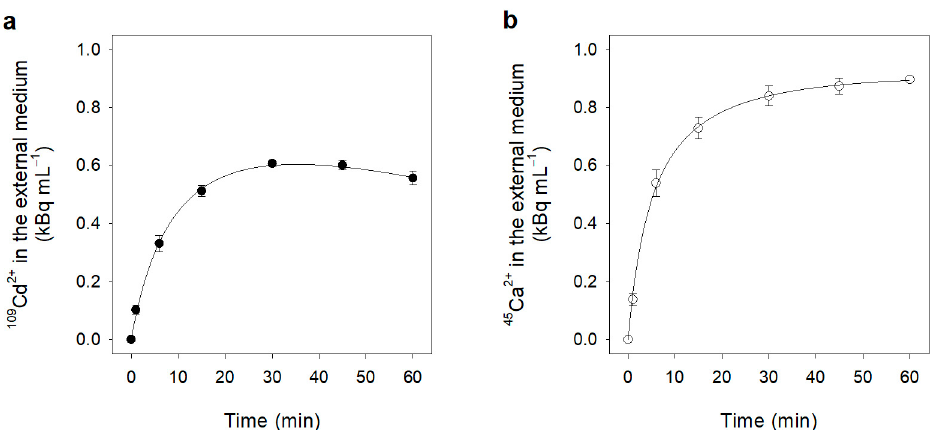
Figure 2. ( a ) Changes in the levels of 109 Cd 2+ in the external medium during the chase phase in pulse-chase experiments. ( b ) Changes in the levels of 45 Ca 2+ in the external medium during the chase phase in pulse-chase experiments. Data are means ± SD of three independent experiments run in triplicate ( n = 3).